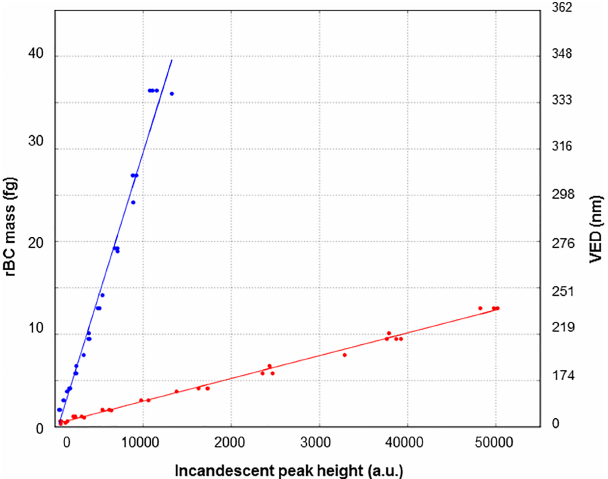
Figure 2. A calibration curve for SP2 no. 58 shows an incandescent peak height with an arbitrary unit response to rBC mass (fg). The data points in blue circles apply to the low-gain channel and those in red circles to the high-gain channel. The right-hand axis shows the volume equivalent diameter (VED) in